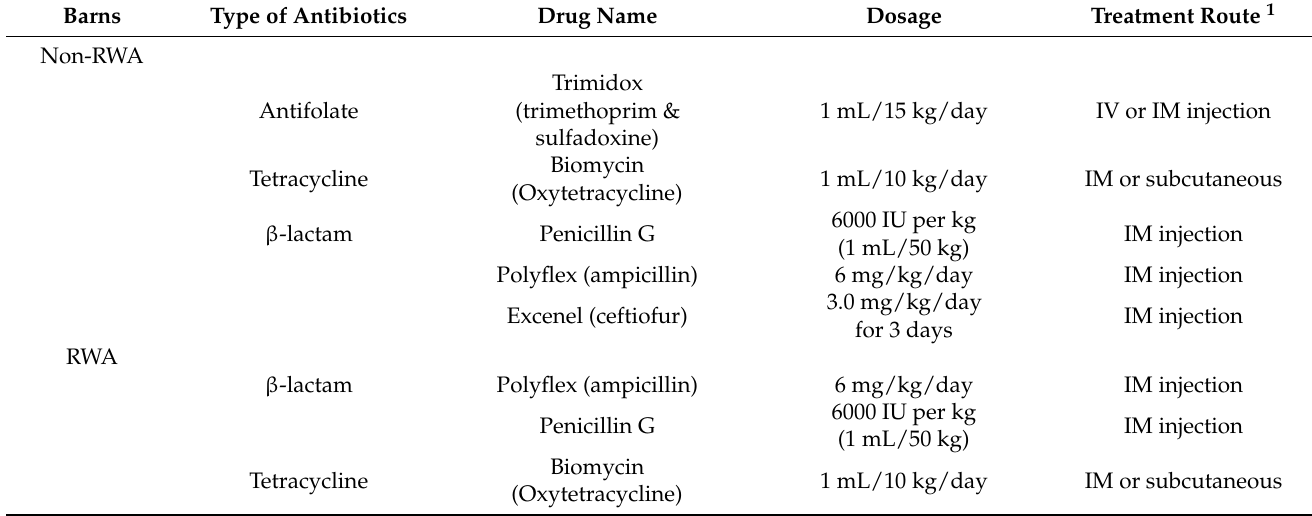
Table 2. Type, drug name, dosages, and route of administration of antibiotics to sows in non-RWA and RWA